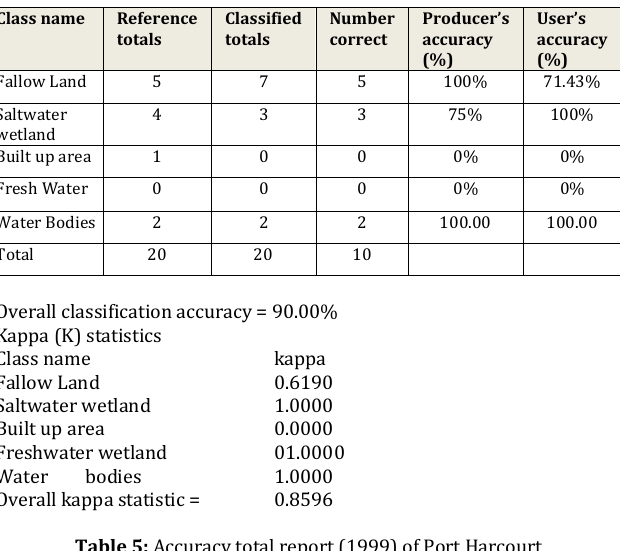
Table 4: Accuracy Total Report (1984) of Port-Harcourt